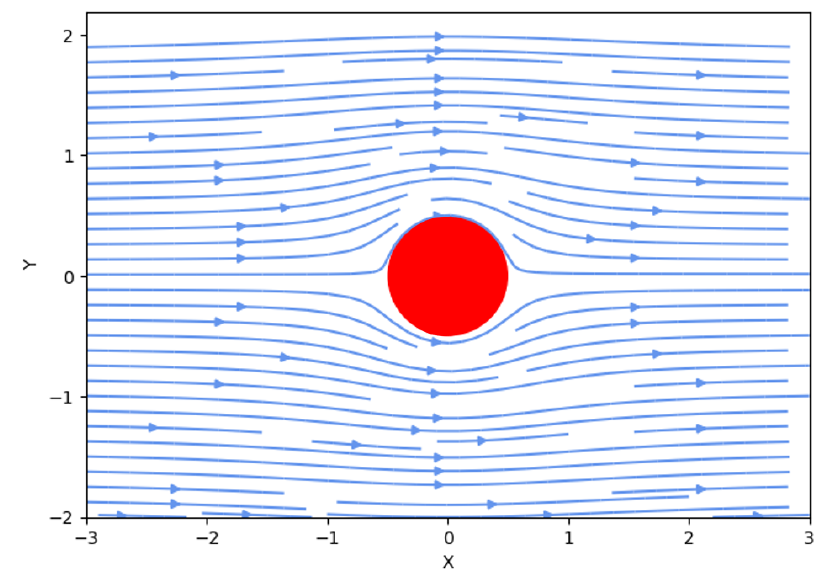
Figure 7. Neural network predicted